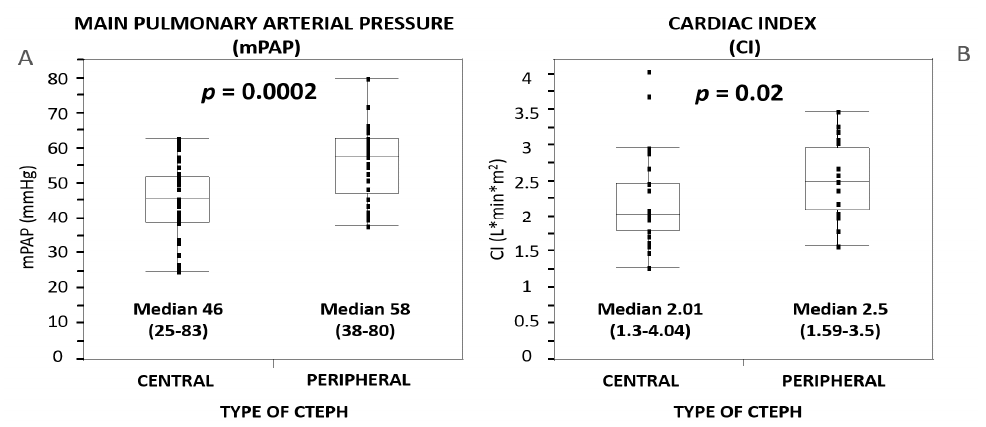
Figure 2. Differences in Group 1 (CENTRAL type) vs. Group 2 (PERIPHERAL type) in hemodynamic parameters: ( A ) mean pulmonary artery pressure (mPAP); ( B ) cardiac index (CI). CTEPH—chronic thromboembolic pulmonary hypertension; CI—cardiac index.